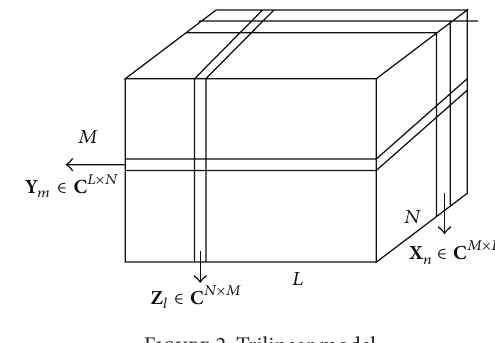
Figure 2: Trilinear model.